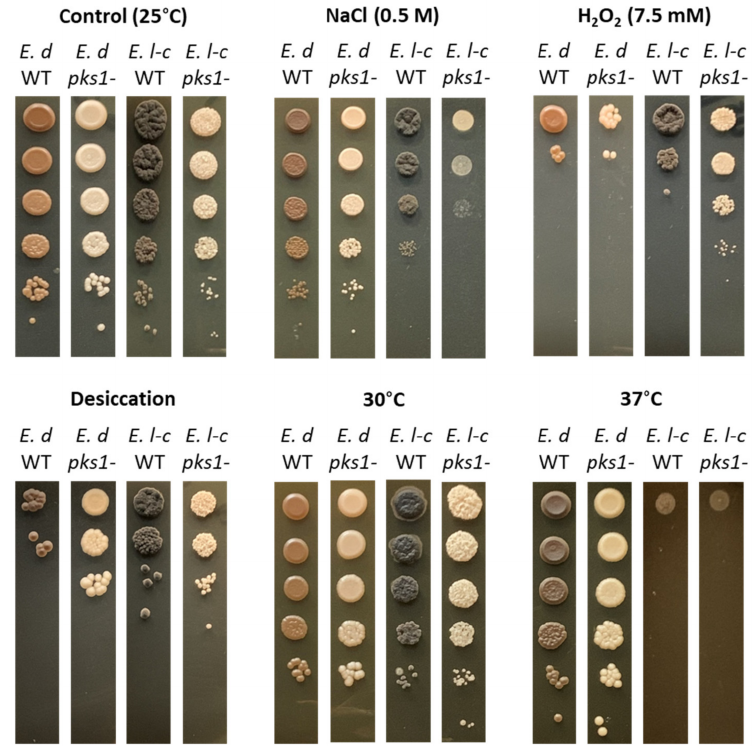
Figure 4. Relative survival of E. dermatitidis WT and pks1 ∆ cells and E. lecanii-corni WT and Elpks1 ∆ cells following exposure to osmotic (NaCl), oxidative (H 2 O 2 ), desiccation, or temperature (30 ◦ C and 37 ◦ C) stress. Each stress assay was performed at least two times with two different biological replicates. Control refers to untreated